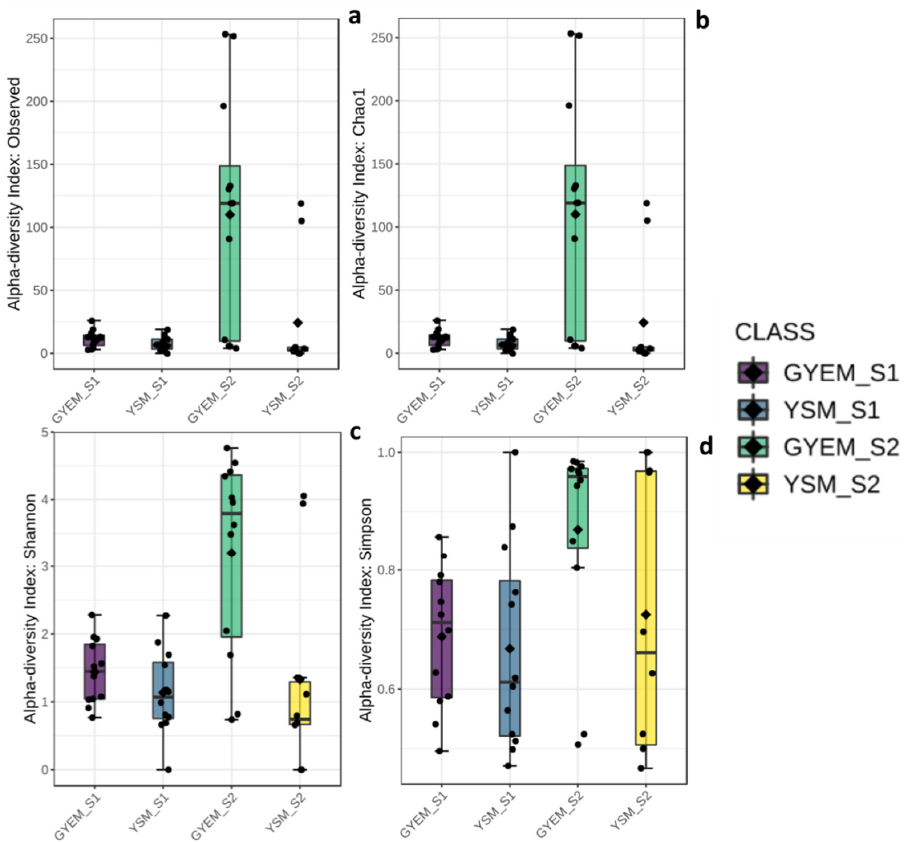
Figure 2. Alpha diversity indices of fungi: ( a )—observed OTUs (richness index), ( b )—Chao1 (total richness), ( c )—Shannon index (richness and evenness) and ( d )—Simpson index (number of species present, as well as the relative abundance of each species).